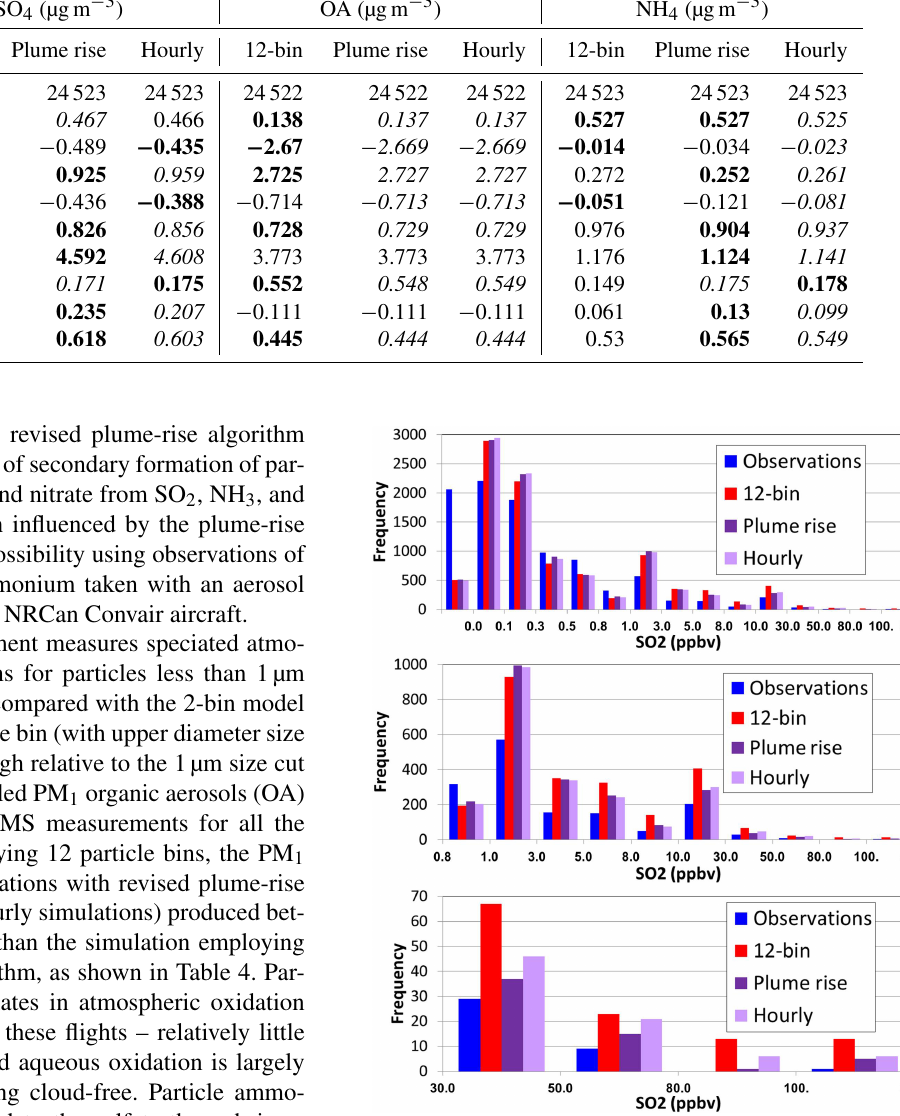
SO 2 observed at WBEA stations, is shown in Fig. 4. The model simulations are biased low for zero concentration lev- els (first bin, Fig. 4a), are biased high from 0.0 to 0.3 ppbv, biased low from 0.3 to 1.0 ppbv (Fig. 4a), and biased high for all concentrations above 1 ppbv (Fig. 4b, c). These last